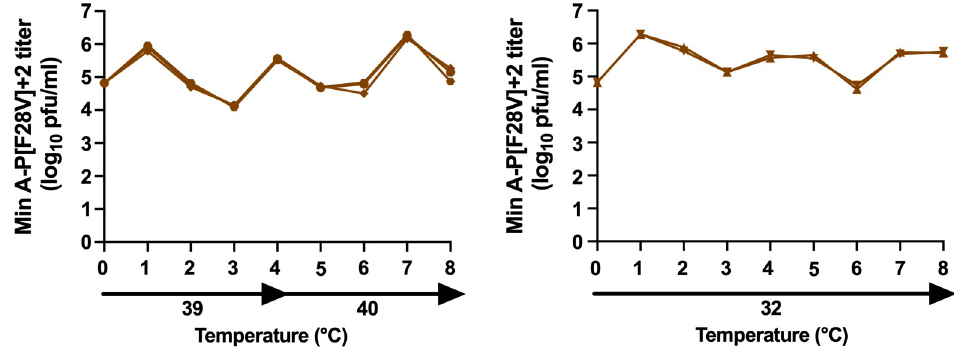
Fig 6. Min A-P[F28V]+2 was phenotypically stable in a temperature stress test. The stability of Min A-P[F28V]+2 that contains the M[K123M] and L[S2084P] mutations in addition of the mutation P[F28V] (see S3 Fig) was evaluated in a temperature stress test. Five replicate cultures of Vero cells in 25 cm 2 flasks were inoculated with an MOI of 0.1 PFU/cell. Three replicate cultures (left panel) were incubated at 39˚C for four passages and 40˚C for an additional four passages, representing two months of culture. The remaining two replicate cultures (right panel) were passaged in parallel for eight passages at the permissive temperature of 32˚C. Flasks were harvested when extensive syncytia were observed or when the cells started to detach. Clarified fluids from the previous passage were used to infect the following passage of fresh cells in a 1:5 dilution. In addition, aliquots of clarified virus from each lineage were snap frozen for virus titration by plaque assay at 32˚C. Whole genome Sanger sequencing was performed at the end of the experiment (P8).